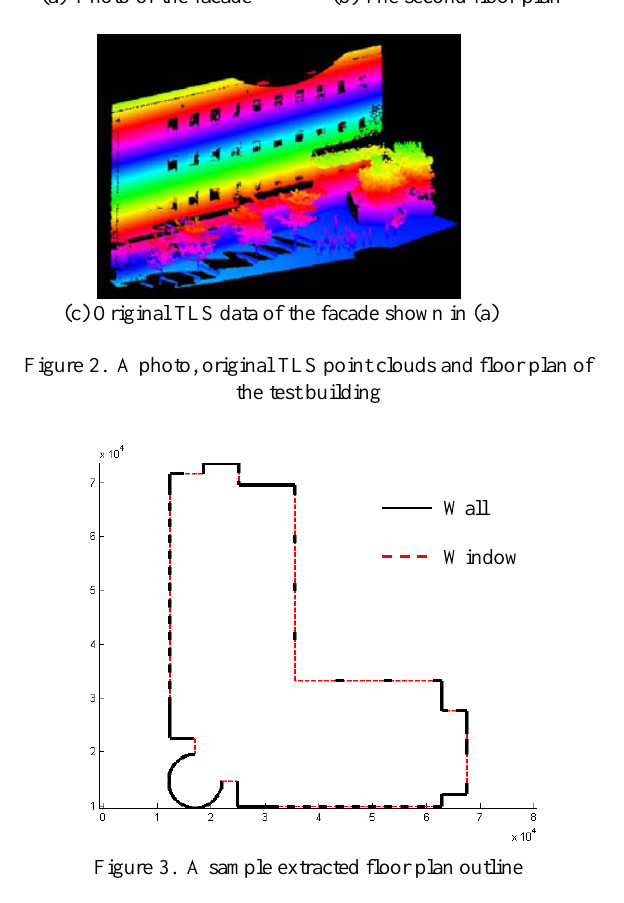
shows an example of the extracted floor plan outline of the second floor. The solid black lines represent wall lines which are originally extracted from the floor plan data. The dashed red line segments are those virtually added which indicate the facade features that cause the gaps between two wall